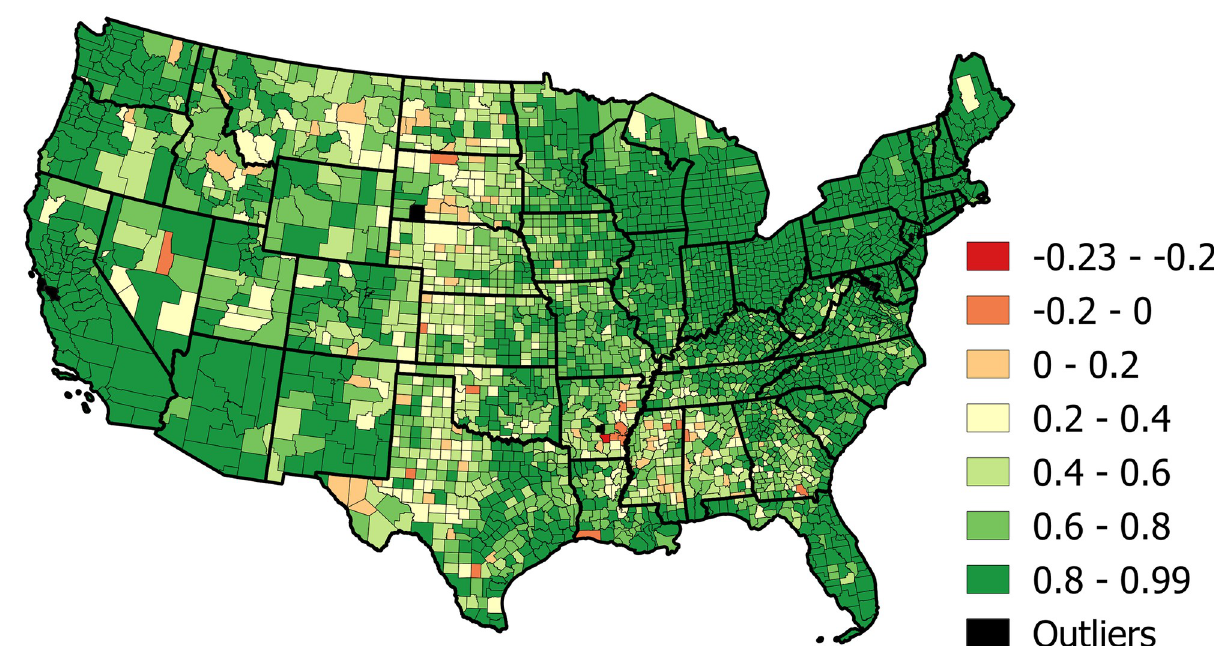
Fig 6. Spatial distribution of the explained variance ( R 2 ) for all counties across the US using three principal components. Map produced in QGIS [30] using SafeGraph [3] derived data, shapefile from data.gov [31].